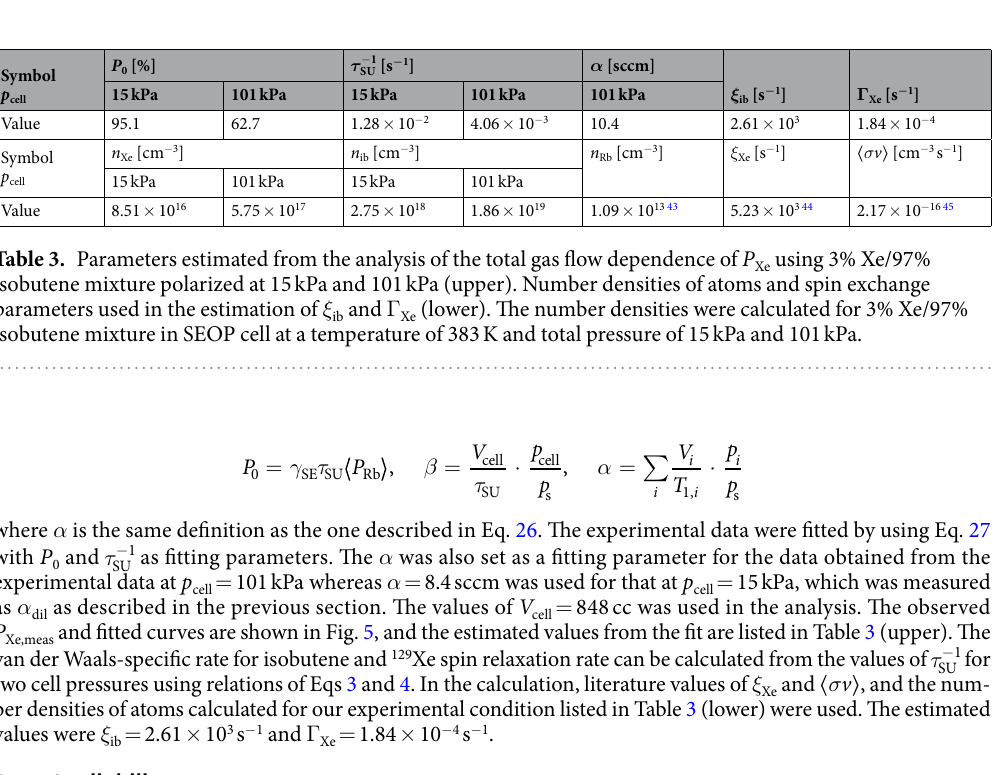
Figure 5. Dependence of P Xe on total gas flow rate using 3% Xe/97% isobutene mixture polarized at 15 kPa and 101 kPa. The experiments were performed without a separation procedure. The solid and dashed lines are the result of the fit using Eq. 27. The coefficient of determination of the fit was R 2 = 0.9991 for 15 kPa and 0.9998 for 101 kPa.